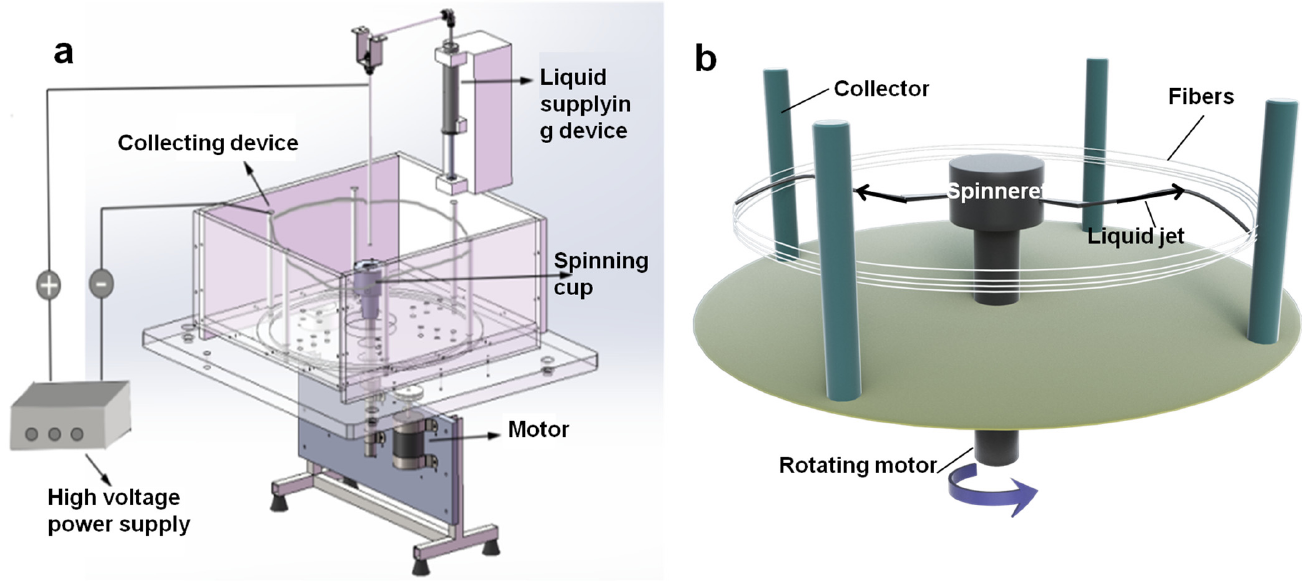
Figure 1. Graphical illustration of the ( a ) ECS setup and the ( b ) formation of PVA fibers.